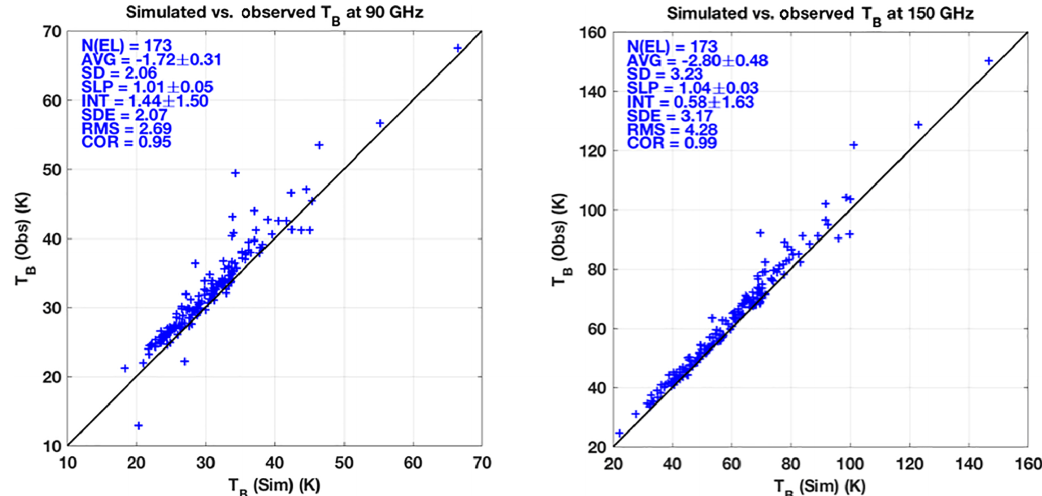
Figure 6. Same as Fig. 4 but showing simulated vs. observed T B at 90 ◦ elevation for two channels of LWP-90-150. Location of radiometer and radiosondes are as in Fig. 5. The absorption model of Rosenkranz (2017) has been used.